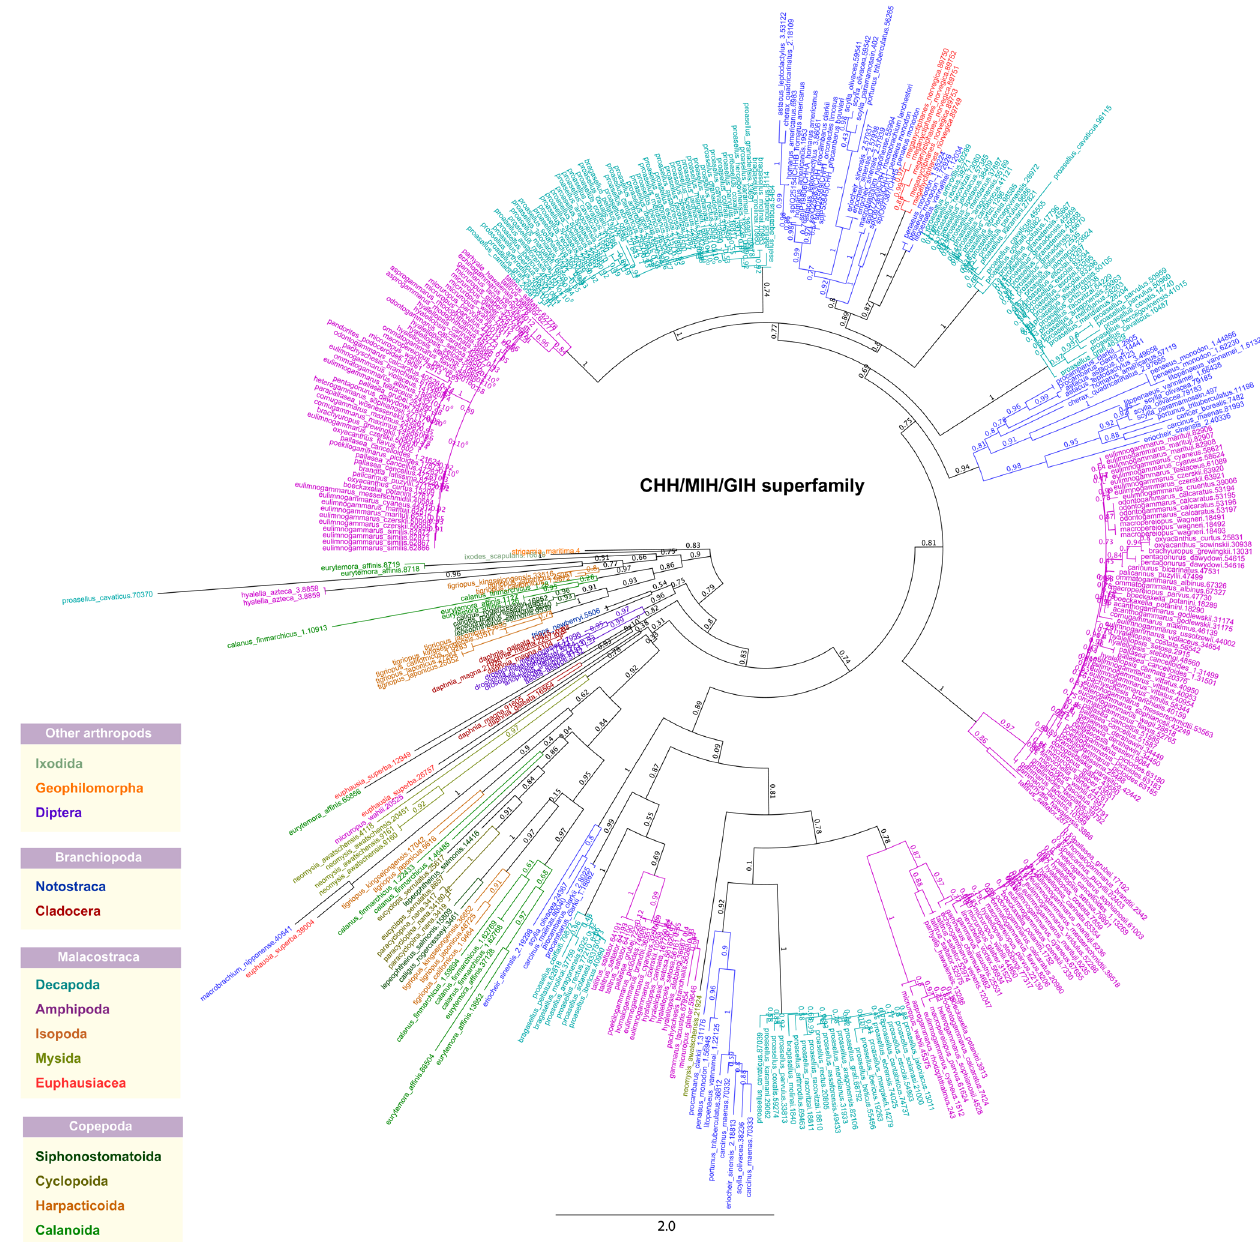
Figure 4. Crustacean CHH/MIH/GIH phylogeny. The tree was constructed using the maximum-likelihood method from an amino acid multiple sequence alignment. The node labels of each taxon are marked with distinctive colors denoted in the figure inset. Bootstrap support values ( n =1000) are denoted as branch